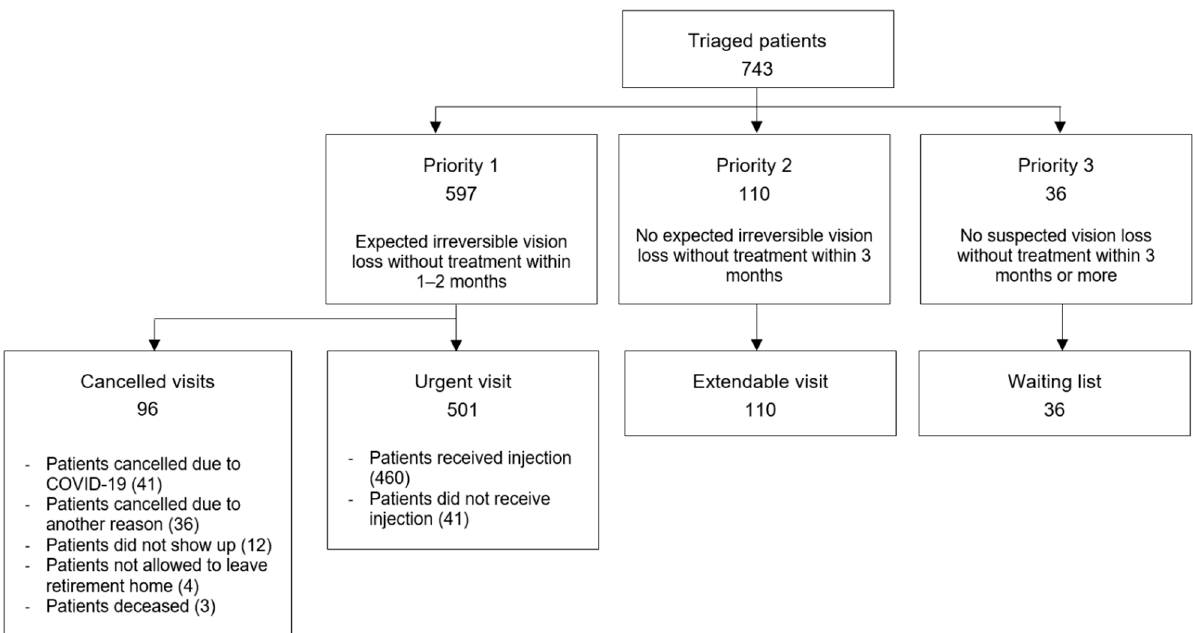
Figure 1. Flowchart outlining the triage used at the medical retina clinic, Department of Ophthalmology, University Hospital of Zurich. Each square contains the number of patients and further descriptions for each group.